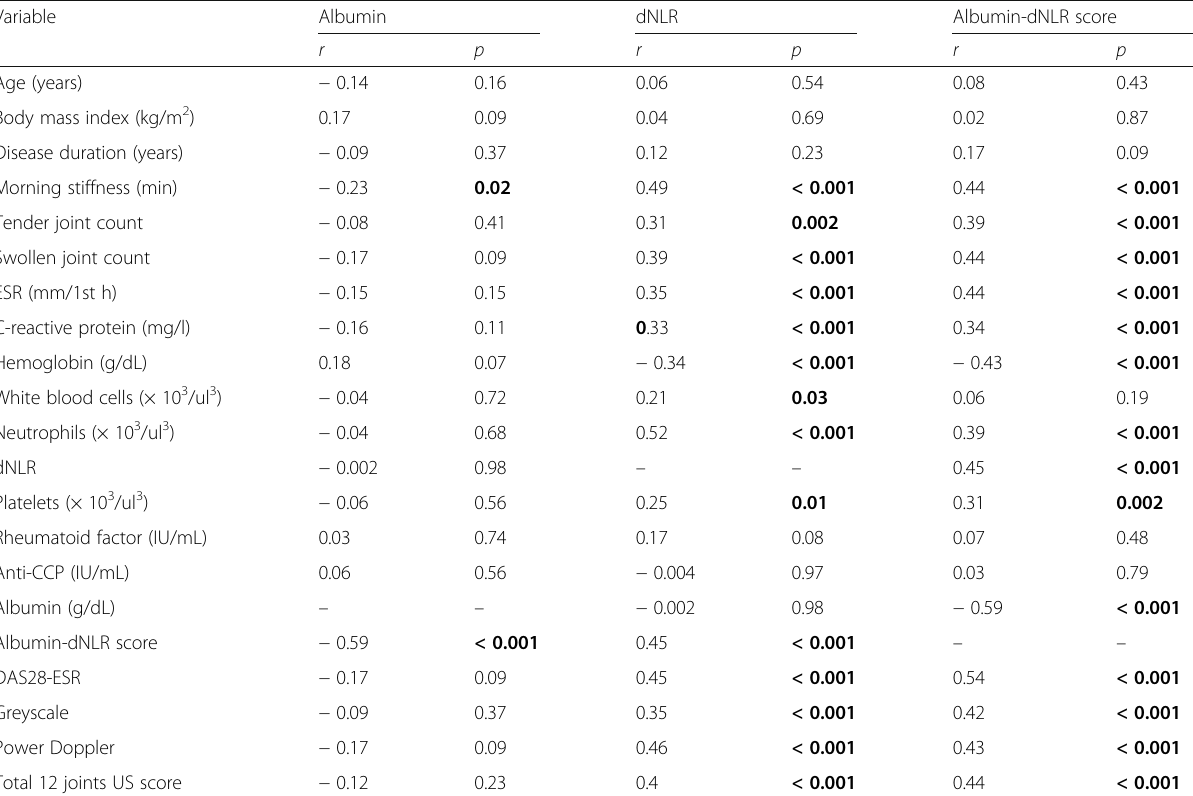
Table 2 Correlations between serum albumin, dNLR and albumin-dNLR score with different variables in rheumatoid arthritis patients